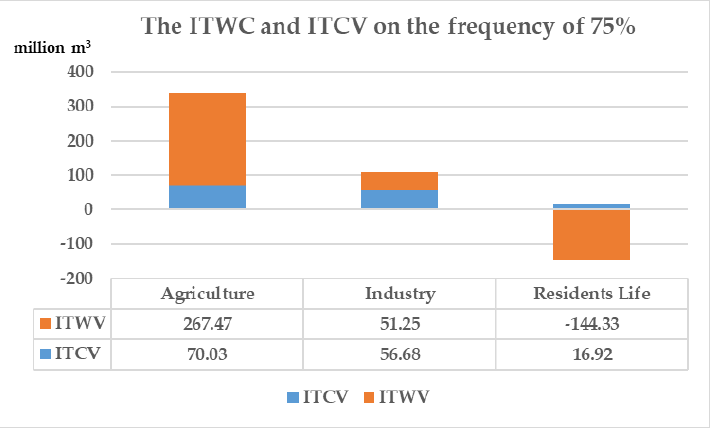
Figure 5. The ITWV and ITCV of industry on the frequency of 75%. (ITWV is short for tradable water volumes of industry. ITCV is short for tradable control volumes of industry.).